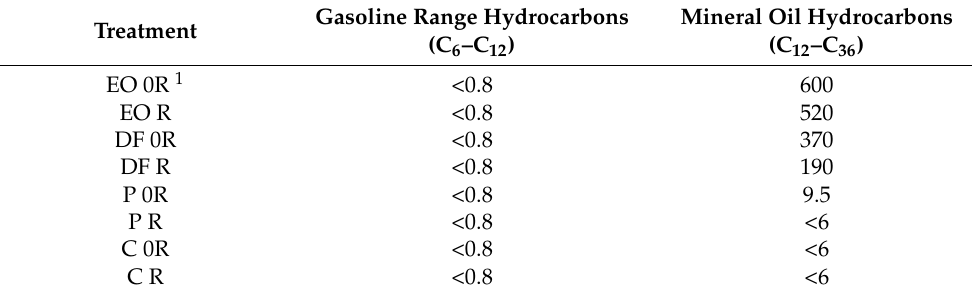
Table 3. The content of hydrocarbons in the soil five years after contamination (mg kg − 1